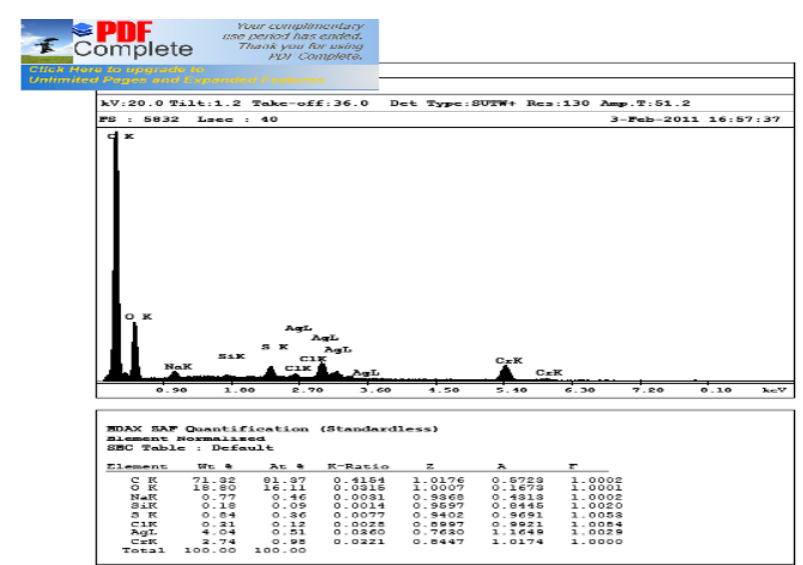
Figure 8. SEM-EDS identification of Ag on dermal layer of sheepskin.